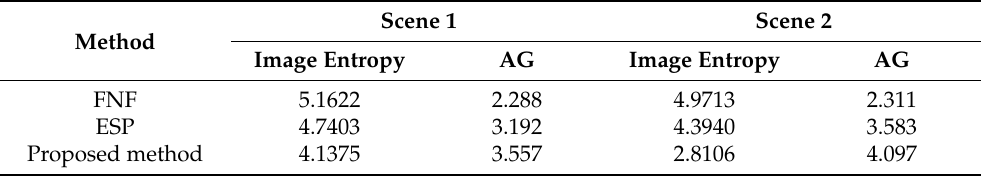
Table 2. The quantitative analysis of the WBI-contaminated measured SAR SLC